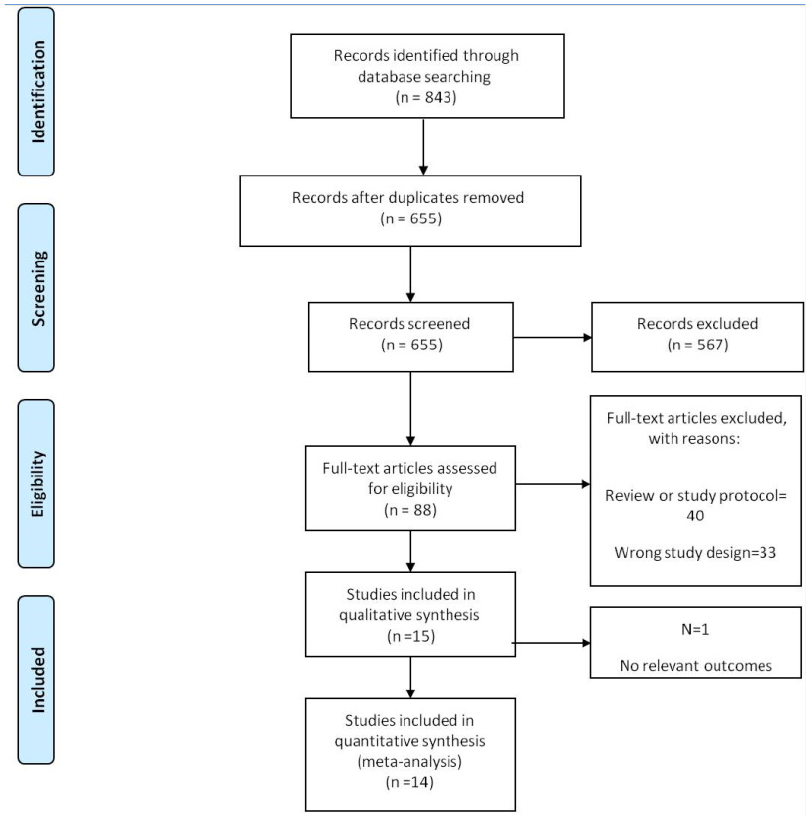
Figure 1. CONSORT flow of identified and appraised publications. RCT, randomized controlled trial.